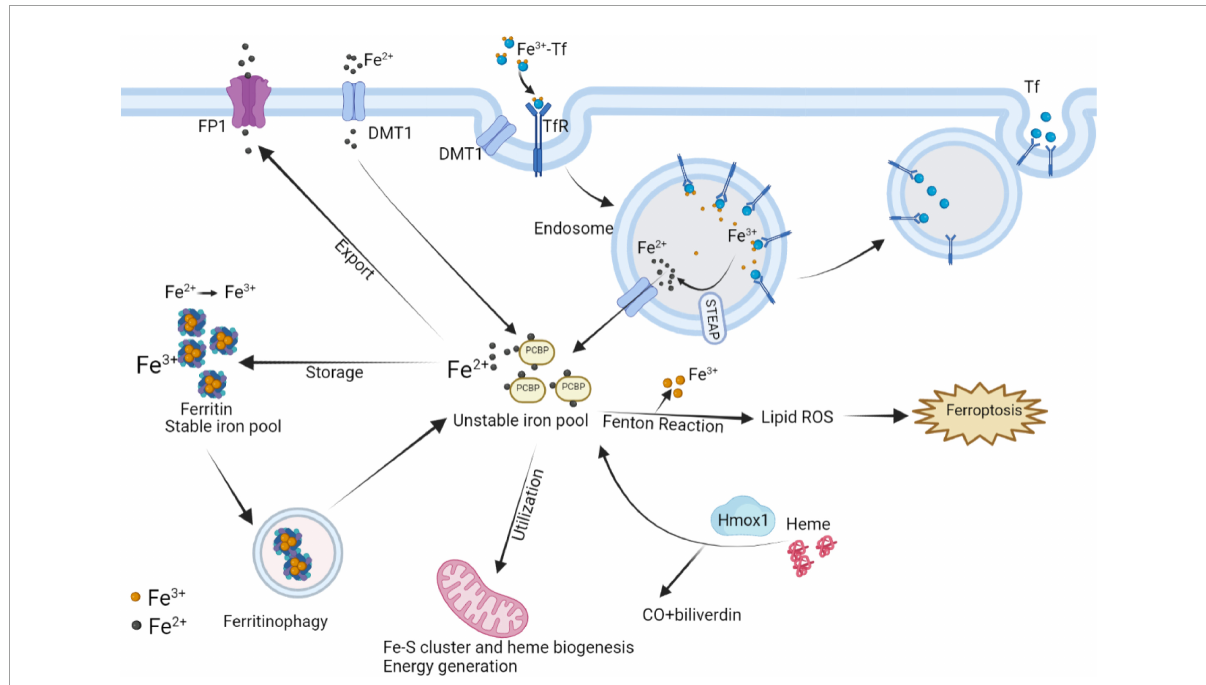
FIGURE5 Interaction of intracellular iron metabolism and ferroptosis. Fe 3 + and Tf bind to form Fe 3 + -Tf complex and enter the cell by means of TfR1 via endocytosis. In endosomes, Fe 3 + is liberated from Tf and catalyzed by STEAP to Fe 2 + , while Tf is released extracellularly by exocytosis. The process Fe 2 + released from endosomes or absorbed into the cells depends on DMT1. In mitochondria, the utilization of Fe 2 + is mainly the synthesis of Fe–S clusters and heme, which can be degraded by Hmox1 to regenerate Fe 2 + . Excess Fe 2 + can store in ferritin by converting into Fe 3 + , while ferritinophagy can re-release free iron. Intracellular Fe 2 + can also be exported through FP1. The above processes participate in the regulation of intracellular Fe 2 + content to control Fenton reaction, thereby regulating the occurrence of ferroptosis. FP1, ferroportin1; DMT1, divalent metal transporter 1; Tf, transferrin; TfR1, transferrin receptor 1; Hmox1, Heme oxygenase 1; STEAP3, six-transmembrane epithelial antigen of the prostate